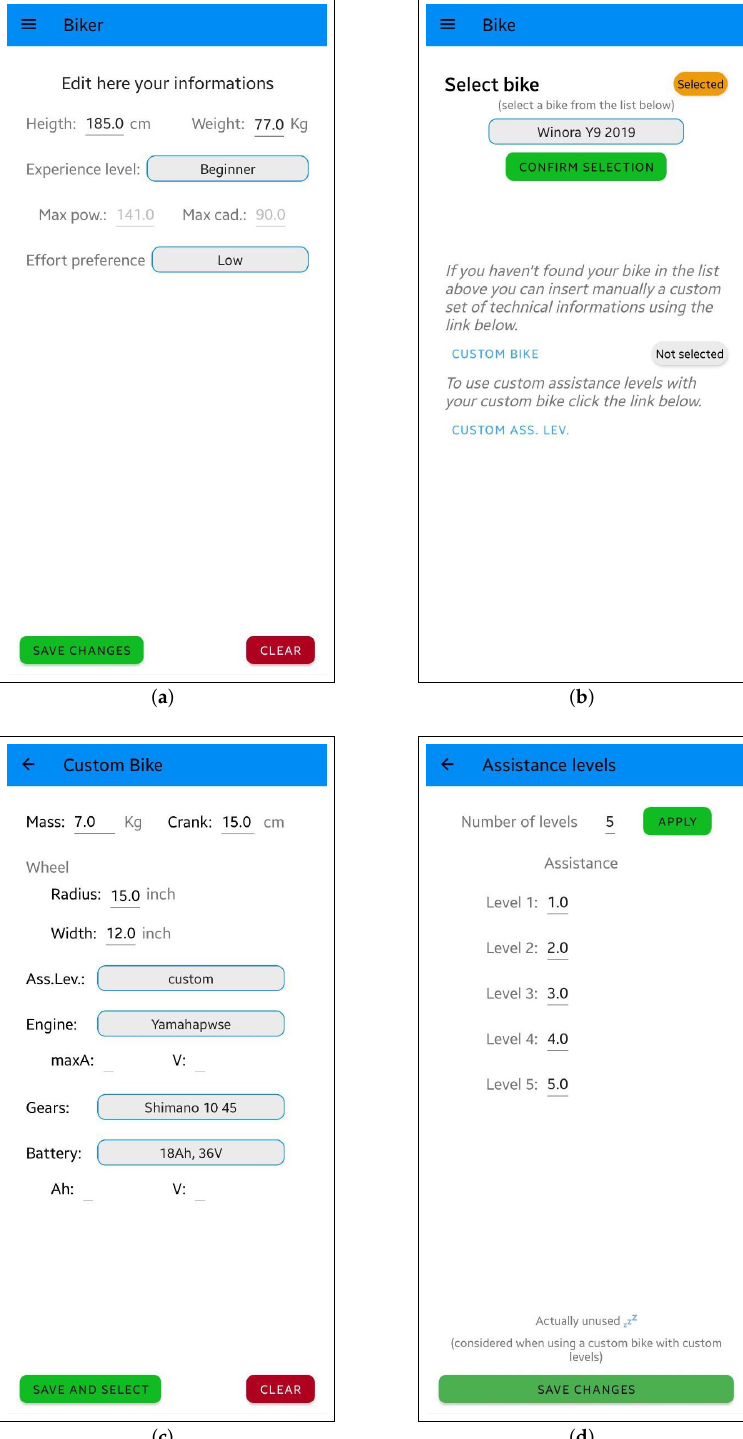
Figure 1. Interface pages to input parameters. ( a ) The form to specify the user’s information. ( b ) The page to select a predefined bike. ( c ) The form to select a custom bike setup. ( d ) The form to define custom assistance